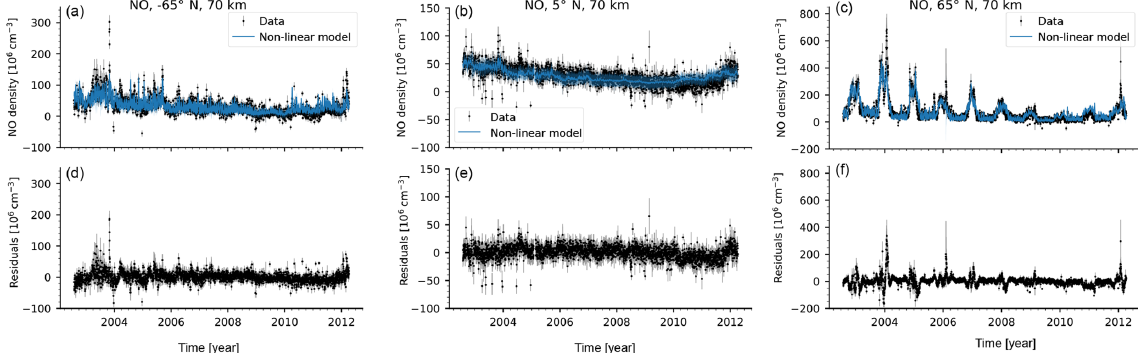
Figure 2. Same as Fig. 1 but for the non-linear